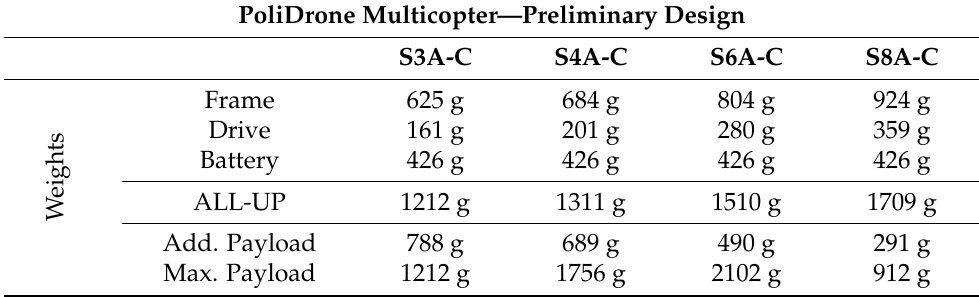
Table 10 discusses the battery-related performance of the UAV: